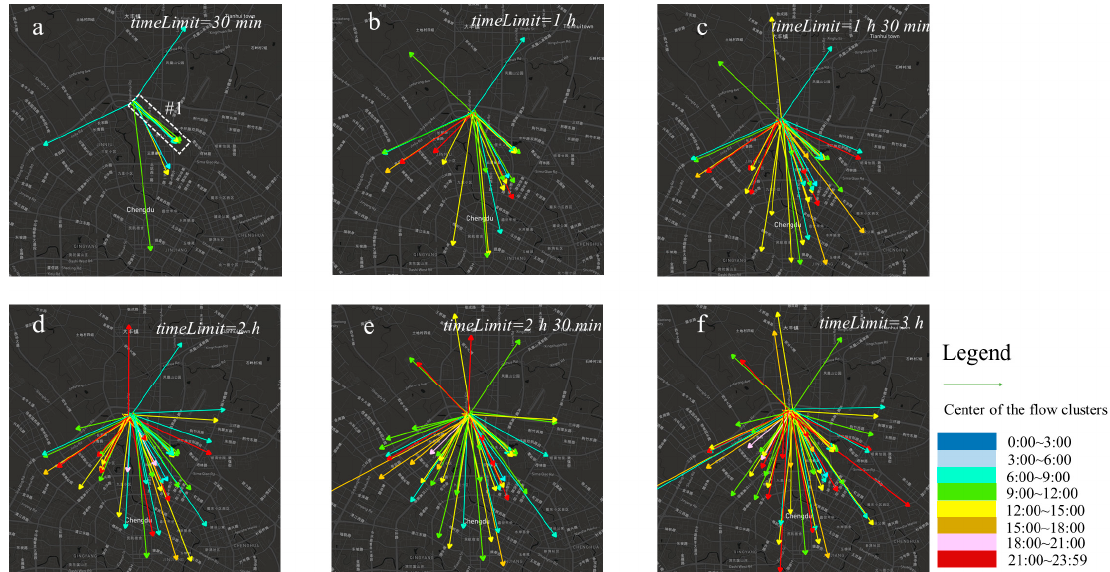
Figure 10. Clustering results produced by the spatiotemporal version of TOCOFC with different timeLimit values. ( a ) Parameter timeLimit is equal to 30 min; ( b ) Parameter timeLimit is equal to 1 h; ( c ) Parameter timeLimit is equal to 1 h and 30 min; ( d ) Parameter timeLimit is equal to 2 h; ( e ) Parameter timeLimit is equal to 2 h and 30 min; ( f ) Parameter timeLimit is equal to 3 h.